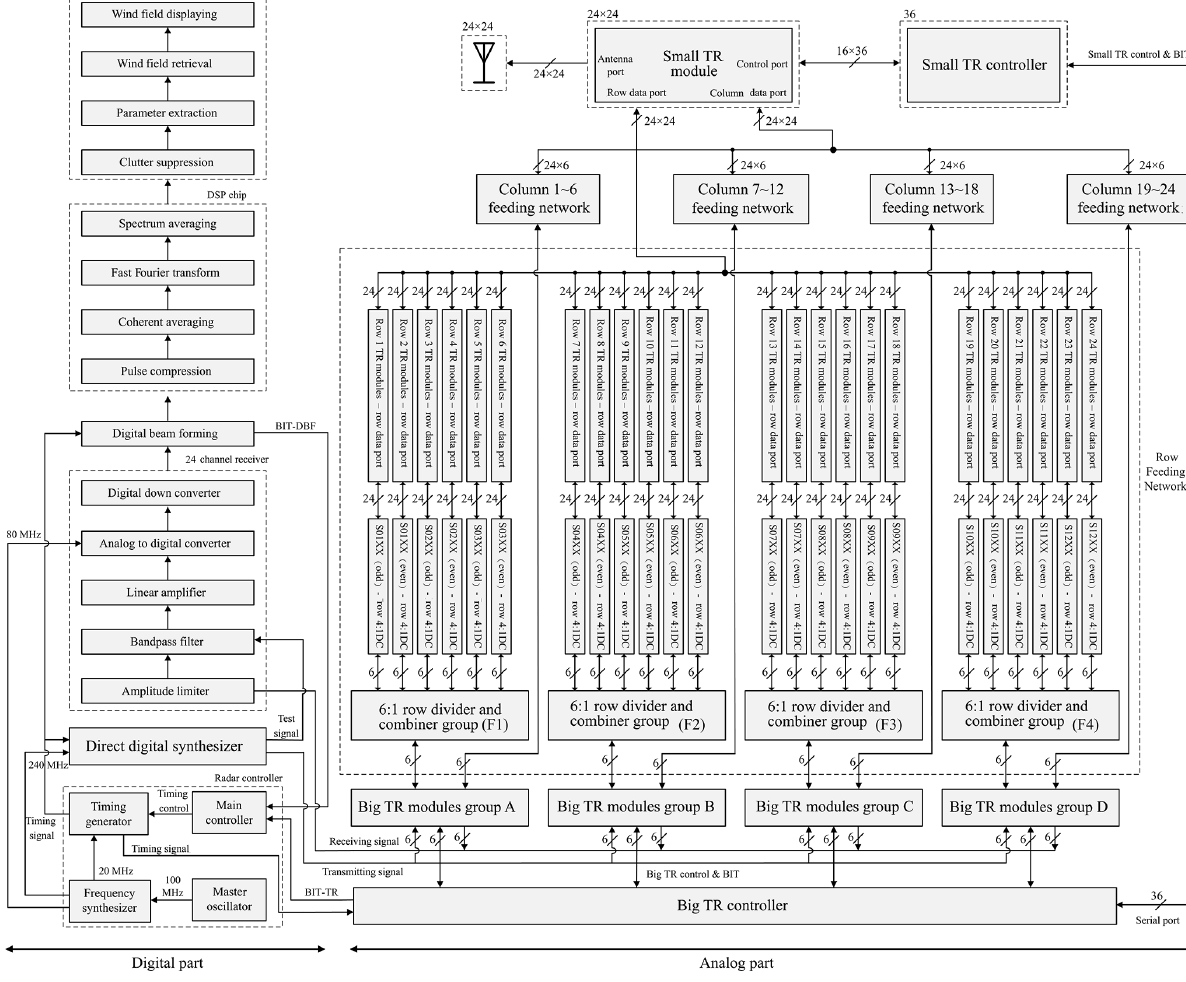
Figure 1. Schematic block diagram of the Wuhan MST radar located in Wuhan, China. The small TR module controllers, the small TR modules, the feeding network, and the antenna array are installed in the antenna field. Other modules are installed in the observation